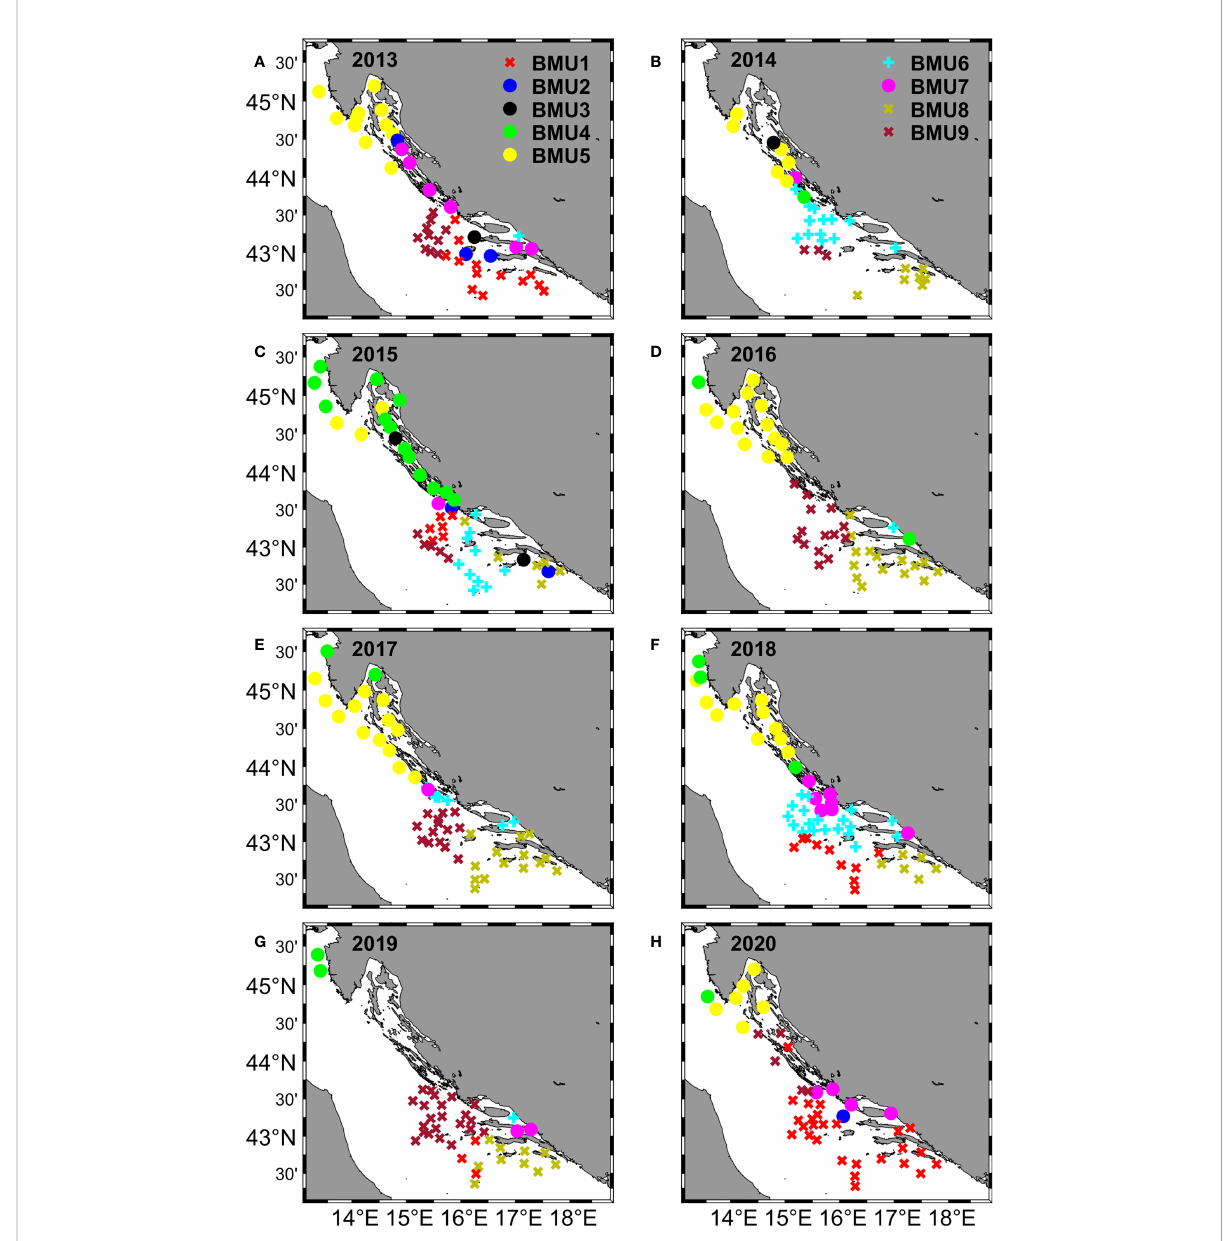
FIGURE 6 Spatial distribution in the eastern Adriatic Sea of the nine Best Matching Units (BMUs) for each year during the 2013 - 2020 survey period (A – H) . BMUs are represented by a different color and are divided into three different groups, identi fi ed by different symbols: X, denoting BMUs with elevated salinity and low numbers of eggs and larvae (1, 8, 9) ) (less abundant BMUs in further text) ; o, denoting BMUs with elevated abundance of eggs and larvae (2, 3, 4, 5, 7) (more abundant BMUs in further text); +, denoting BMUs with low salinity and low numbers of eggs and larvae